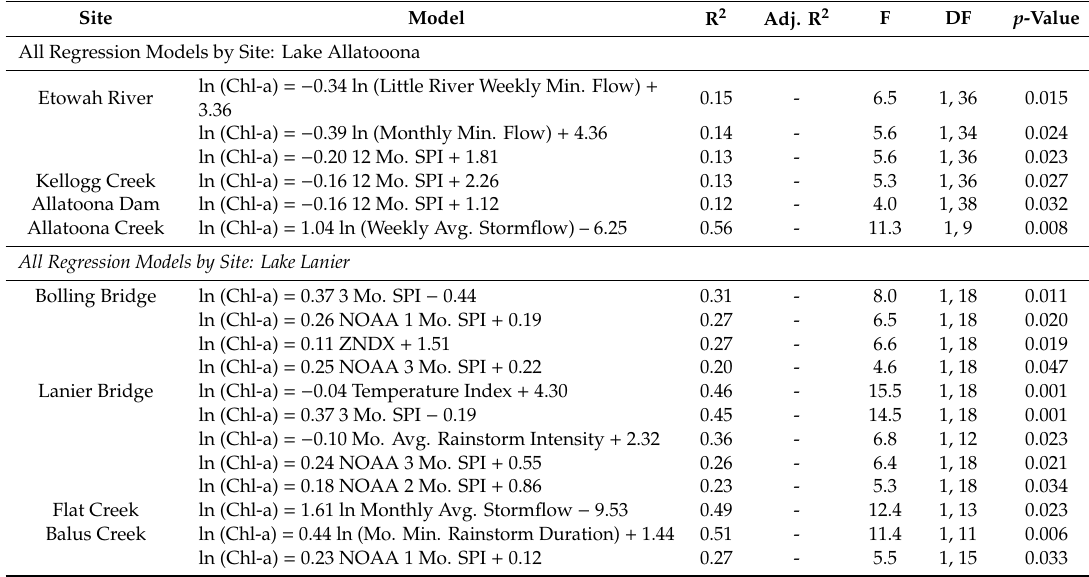
Table A2. The relationship between chlorophyll-a and Weekly Average Stormflow shows an increasing e ff ect size, variance explained, and statistical significance with increasing distance from the Etowah River Inflow (Compare with Figure 2). Table A3. Regression Models by Lake and Site at Lake Allatoona and Lake Sidney-Lanier.